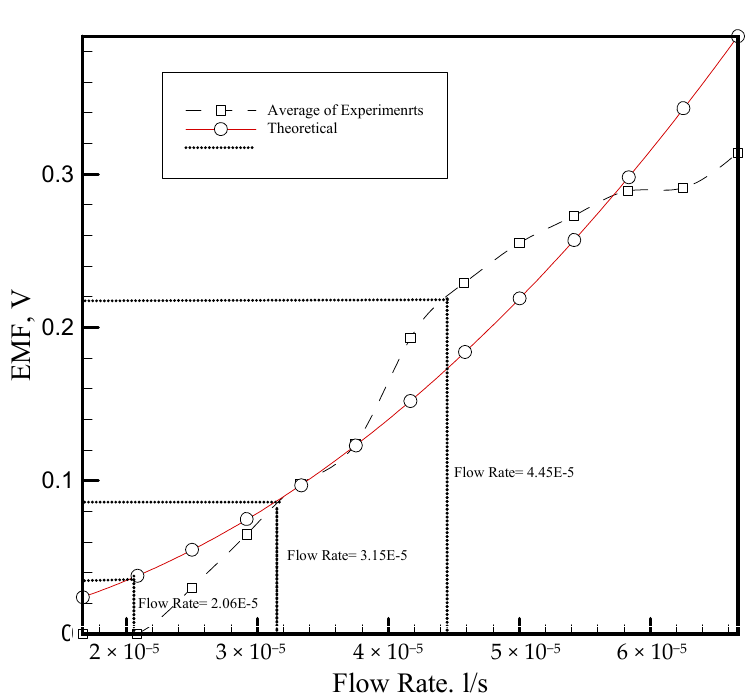
Flow Rate. l/s Figure 11. Estimating power output of varying rainfall Figure 11. Estimating power output of varying rainfall intensities.